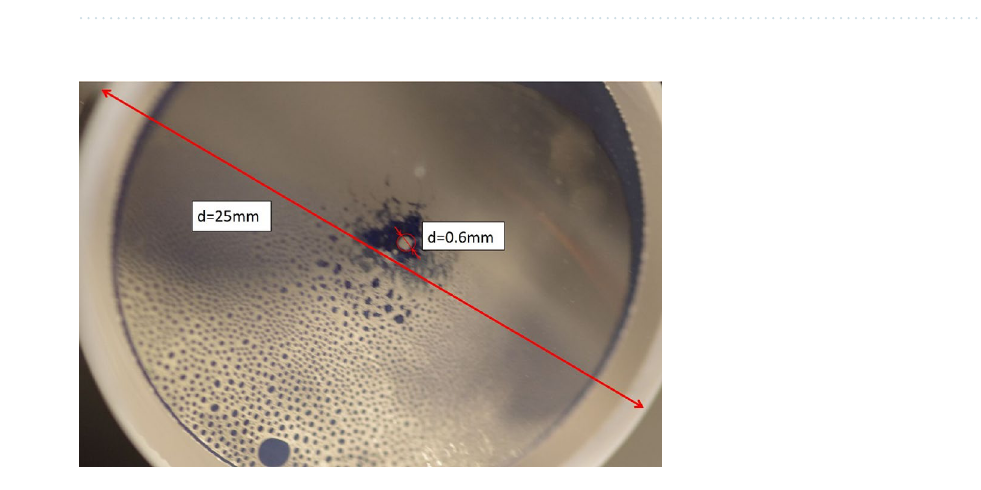
Figure 3. Setup of the laser cleaning of the Rubidium cell. The apparatus to capture the emission signal of microplasma eventually ignited during the removal of the residues is detailed in the figure.